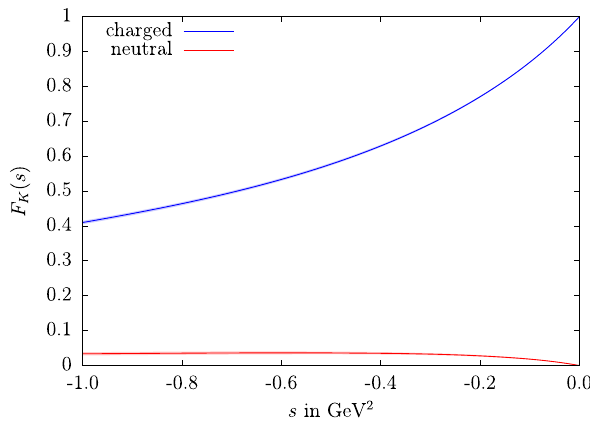
Fig. 9 The charged (blue) and neutral (red) kaon form factors in the spacelike region as determined in Sect.